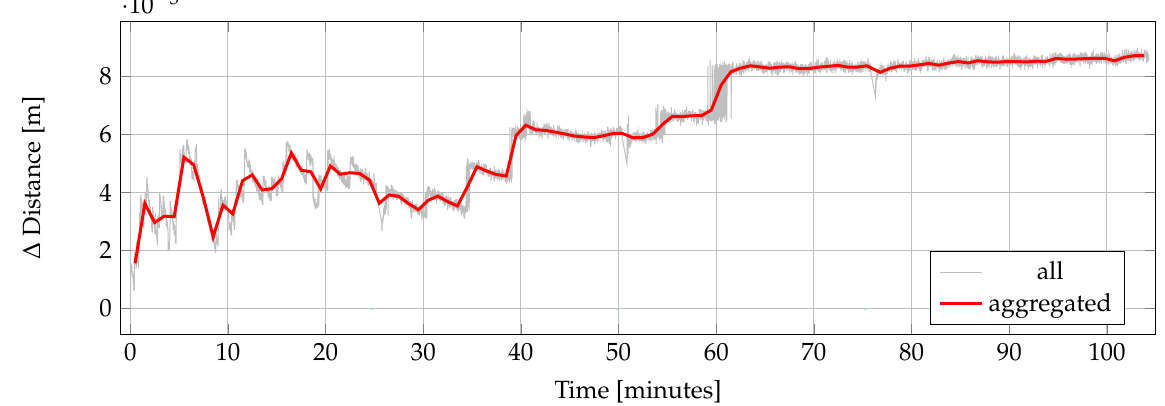
Figure 7. Change in distance measurement of the HoloLens range sensor relative to the start value over time during the warm-up process of the device. Vertical green lines indicate when the recording of range measurements had to be stopped and immediately restarted to prevent the device from switching to sleep